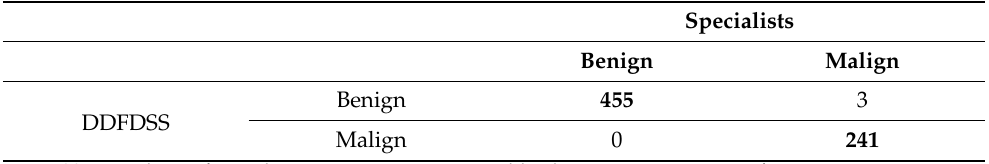
Table 2. Performance metrics obtained with the proposed framework.